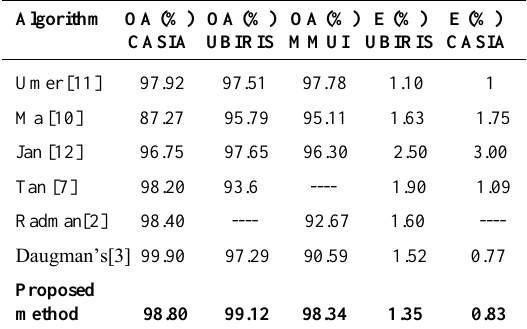
Table 6. Efficiency comparison on MMUI, UBIRIS and CASIA database images for popular algorithms (Overall Accuracy (OA), Segmentation Error Rate (E), UBIRIS).